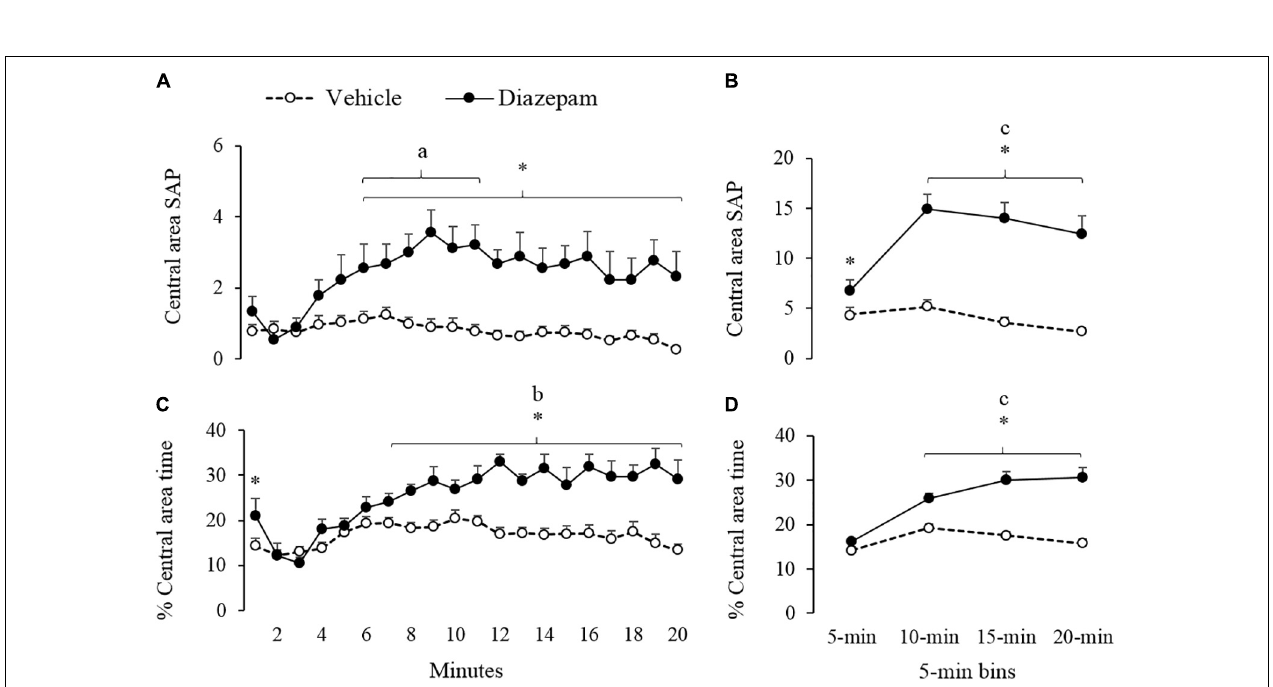
FIGURE 3 | Effect of DZP on the approach to the closed arms of gerbils exposed to 20-min session in the EPM – i.e., percentage of entries and distance run (m). The left panels show minute-by-minute data (Panel A , C ) and right panels show data in 5-min bins (Panel B , D ). After 5-min of exposure to the EPM, DZP increased the approach to the closed arms of the maze. a different from minute 1 to 4 for vehicle and DZP group, b different from 5-min bin for DZP group, ∗ different from vehicle group ( p < 0.05).